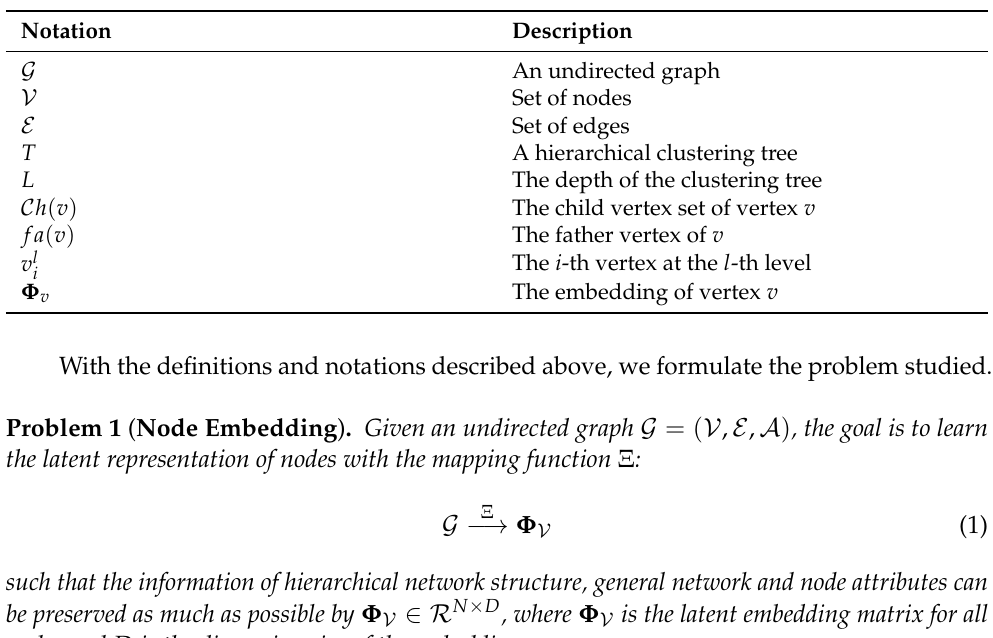
Table 1. Main notation used across the whole